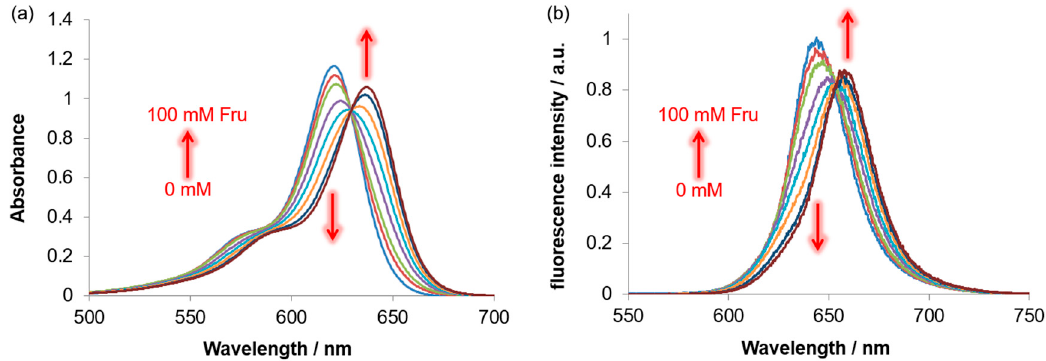
Figure 5. Effect of different concentrations of Fru (0, 1, 2, 5, 10, 20, 50, and 100 mM) on the ( a ) absorption spectra, and ( b ) fluorescence spectra (excited at 621 nm) of BRhoC (8.5 µ M) in a 10 mM HEPES buffer at pH 7.4.